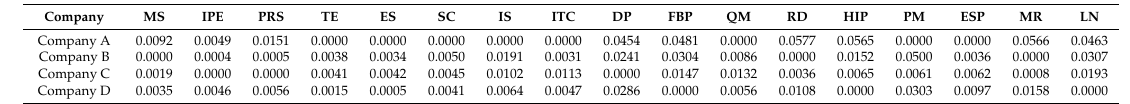
Table 8. The distance between the negative solution.